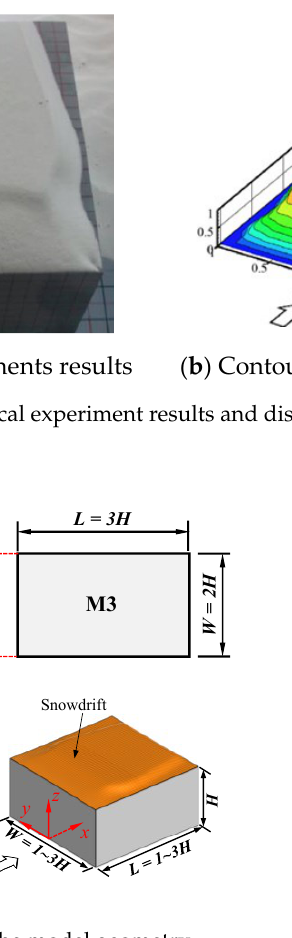
Figure 2. Schematic map of the model geometry.